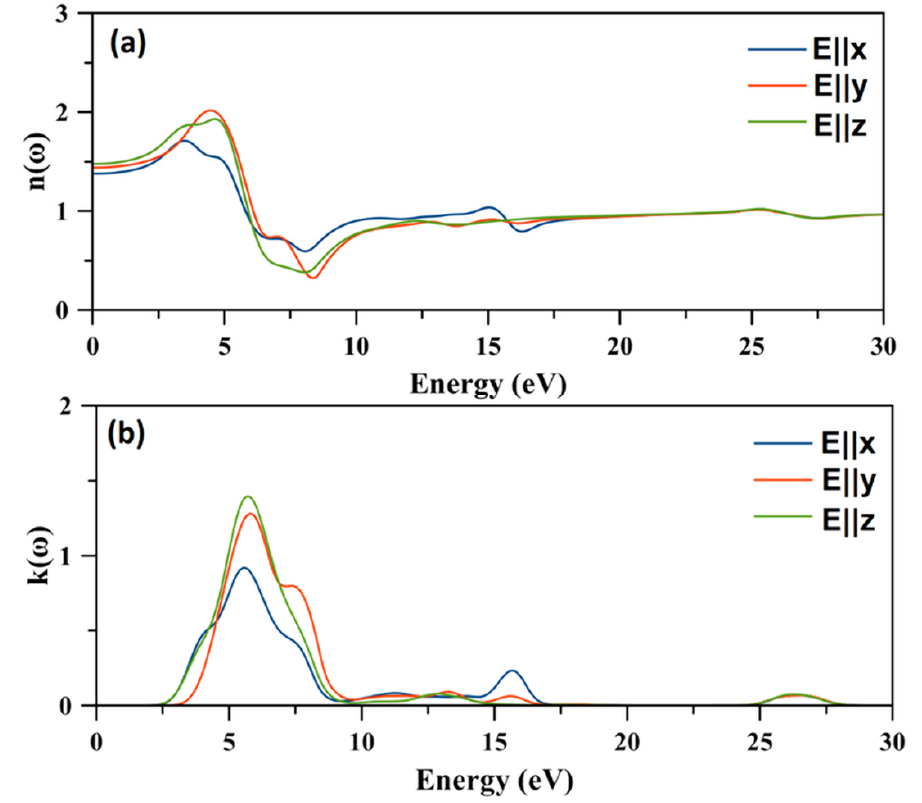
Figure 13. Variation of ( a ) the refractive index n ( ω ) and ( b ) the extinction coefficient k ( ω ) as a function of the energy of the (C 2 H 7 N 4 O) 2 BiCl 5 compound.